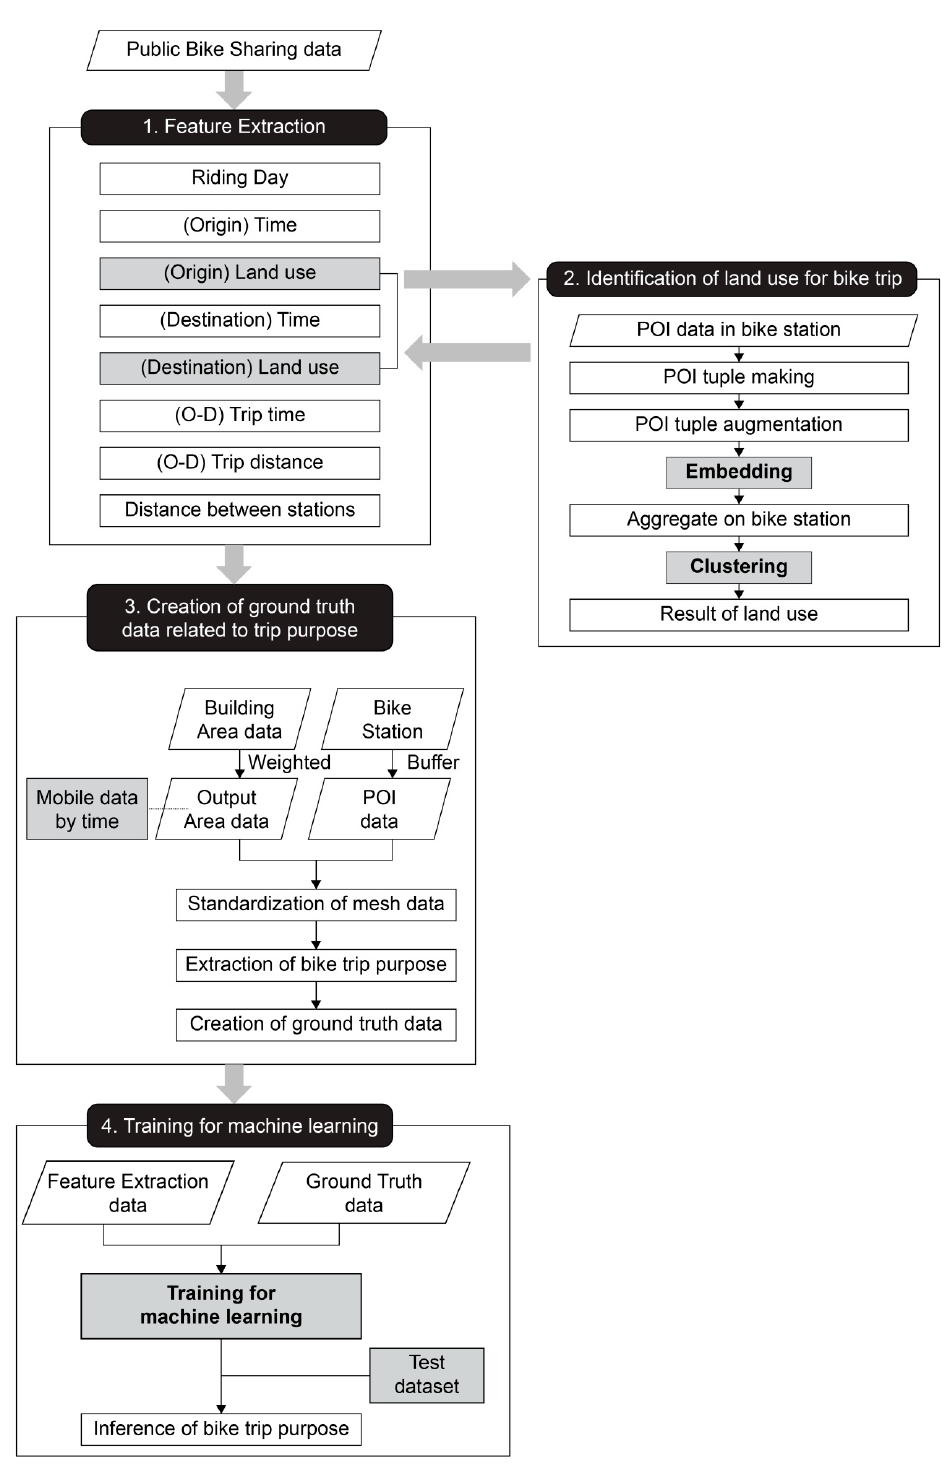
Figure 1. Flow chart of the proposed bike trip purpose inference method.